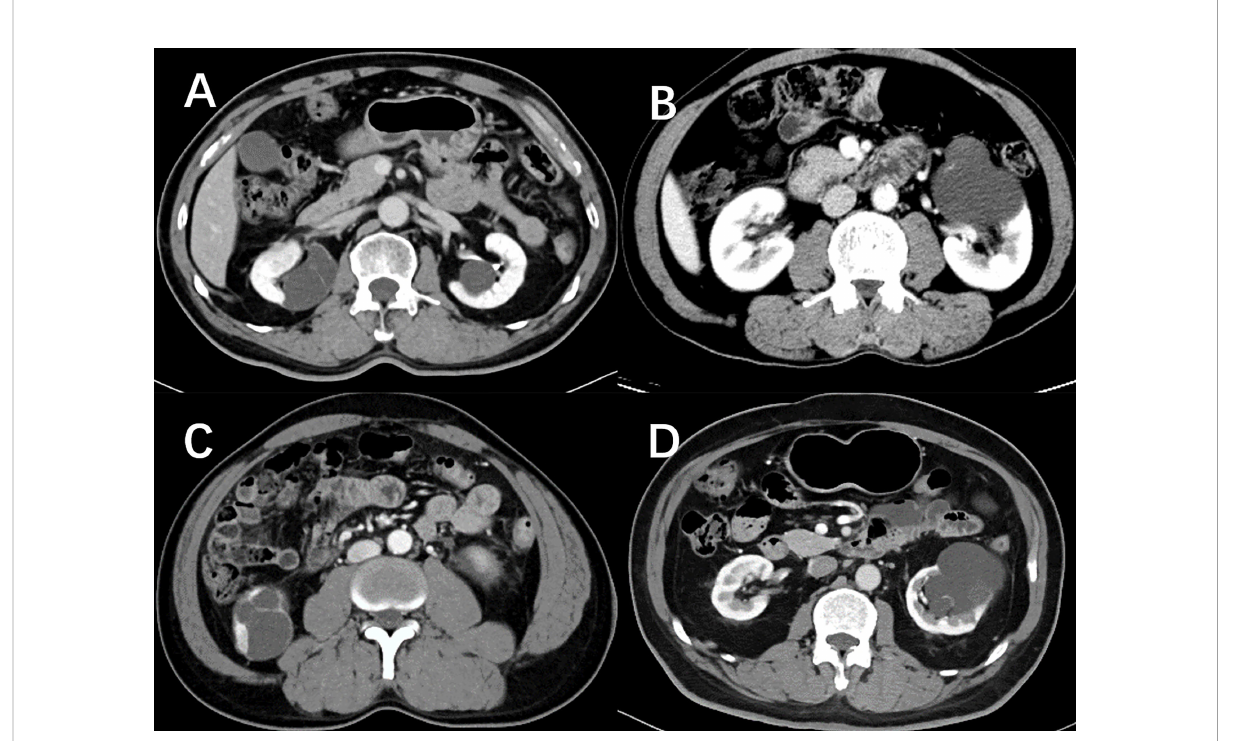
FIGURE 7 Nephrographic phase images for four cystic renal lesions in the testing datasets. Cystic renal lesion in (A) is benign 2019 Bosniak II lesion and cystic renal lesion in (C) is identi fi ed as clear cell renal cell carcinoma according to the histopathologic results after surgery, which stacking model properly predicted as cystic renal neoplasms. Cystic renal lesion in (B, D) are classi fi ed as 2019 Bosniak IIF, which are accurately identi fi ed as benign CRL by the stacking machine learning